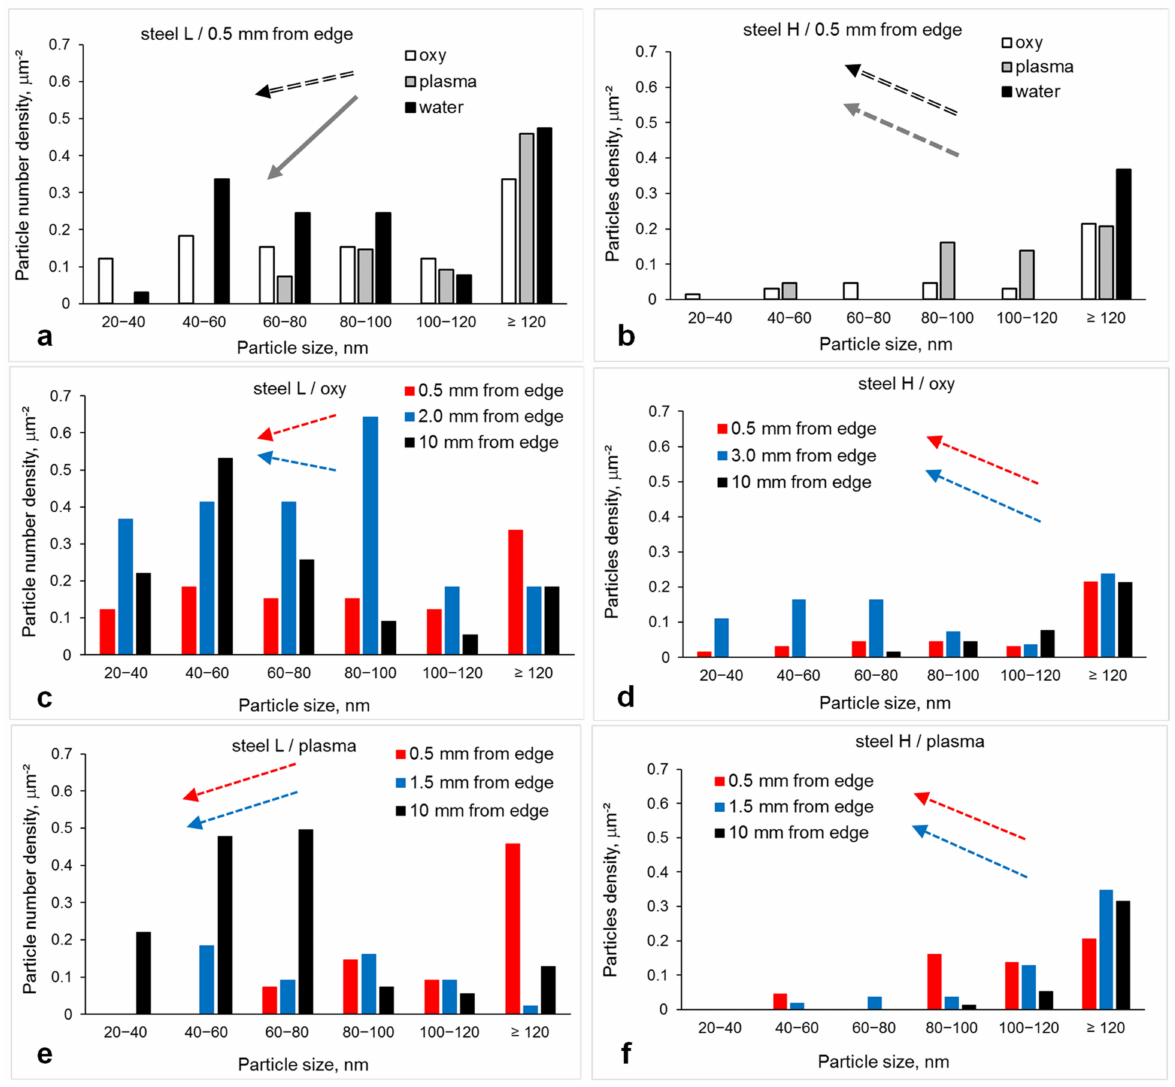
Figure 11. Fine Ti-rich particle number density distributions at 0.5 mm position from the cut edge for Steels ( a ) L and ( b ) H, for the samples cut with oxy-fuel for Steels ( c ) L and ( d ) H, and for the samples cut with plasma in Steels ( e ) L and ( f ) H; arrows in ( a , b ) indicate the directions of distributions peaks shift for oxy-fuel and plasma cutting methods with respect to the distribution observed for the water jet cutting, and these in ( c – f ) indicate the directions of distributions peaks shift for 0.5/2.0/3.0/1.5 mm positions with respect to the distribution for the 10 mm